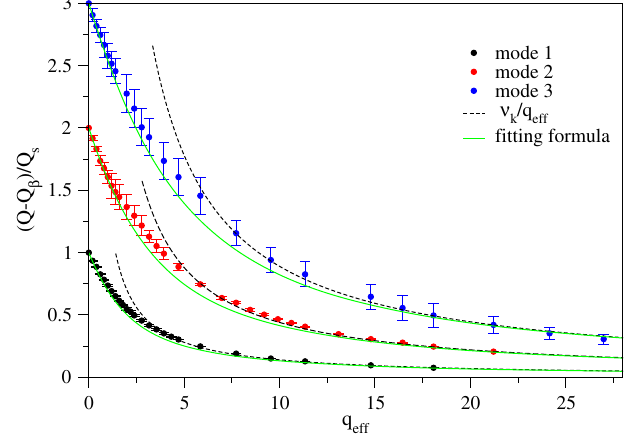
Q − Q β , for the Q s . In the eff ≈ ν k , in good agree- Q s q eff